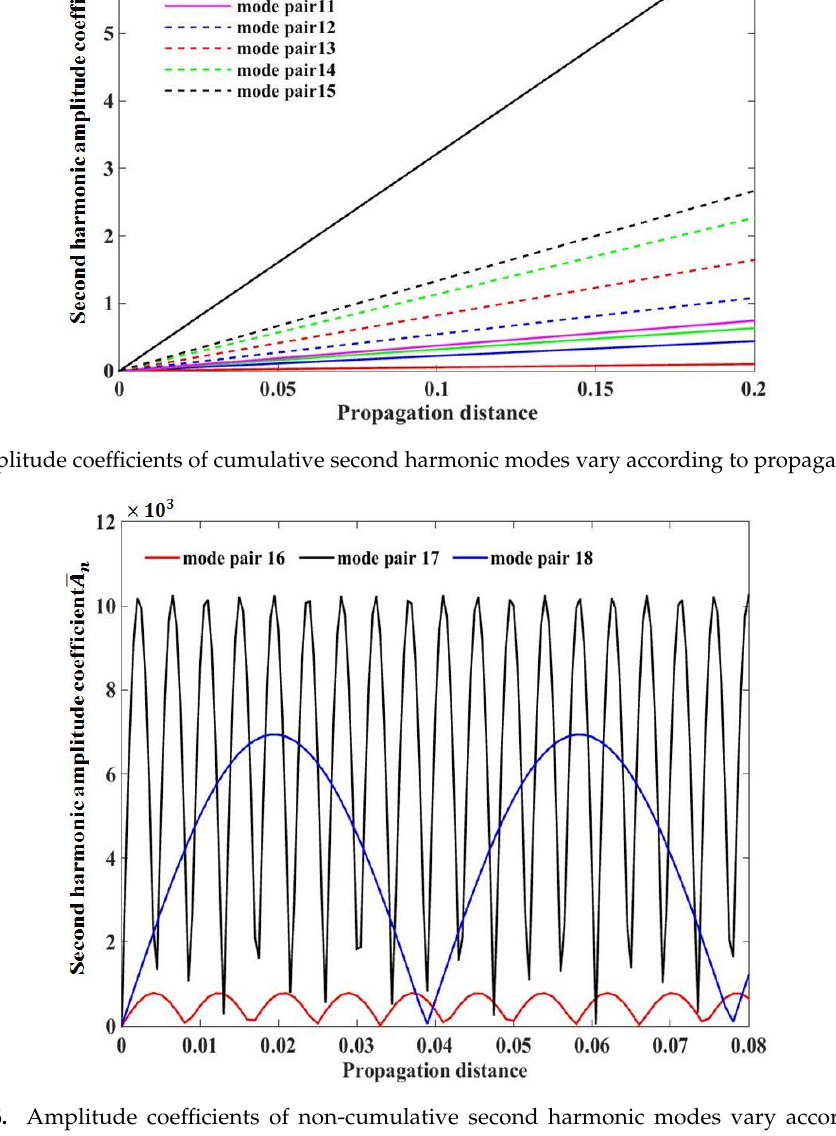
Figure 6. Amplitude coefficients of non-cumulative second harmonic modes vary according to propagation distance.